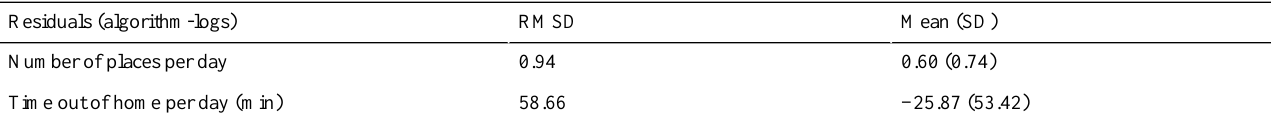
Table 1. Comparison between metrics calculated from log sheet and algorithm trajectories. Residuals are calculated by subtraction of log sheet results from algorithm results, and are used to calculate root mean square deviation (RMSD) and mean (SD).